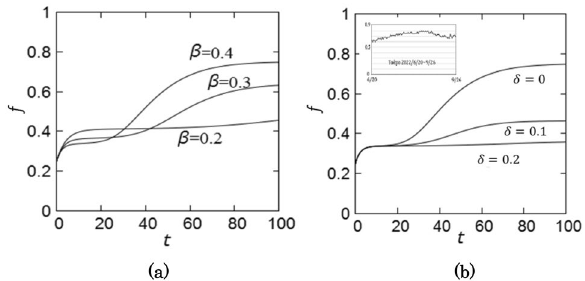
Figure 5. The fraction of untraceable patients in the daily confirmed new cases. ( a ) β = 0.4 , 0.3, 0.2 for δ = 0.0 and ( b ) δ = 0, 0.1, 0.2 for β = 0.4 . The inset in ( b ) shows the fraction of untraceable patients in Tokyo from 2022/6/20 to